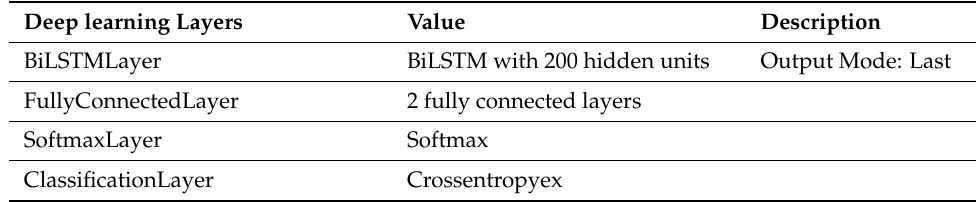
Table 1. Deep learning layers and network training